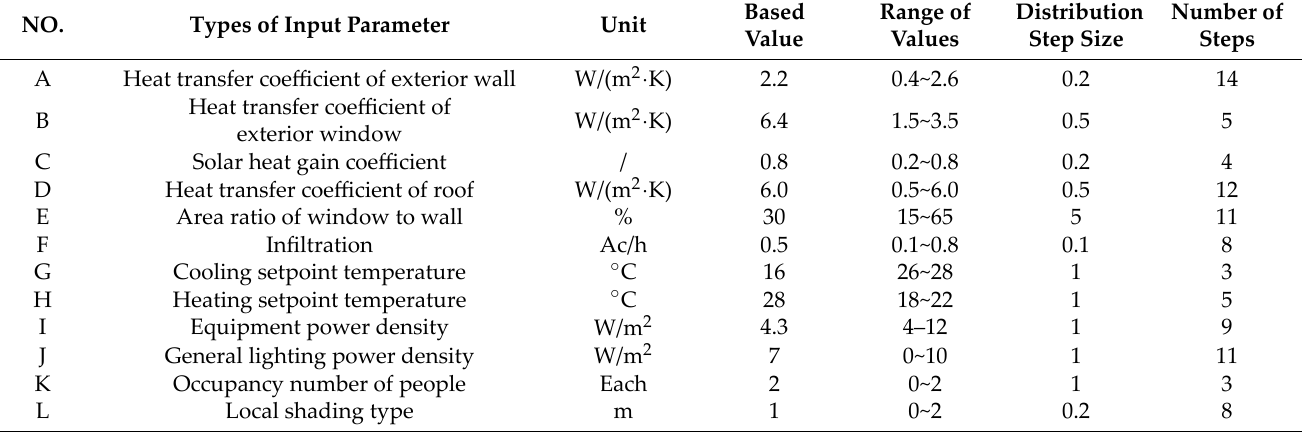
Table 3. Range of intervals for the base line and simulated values of each